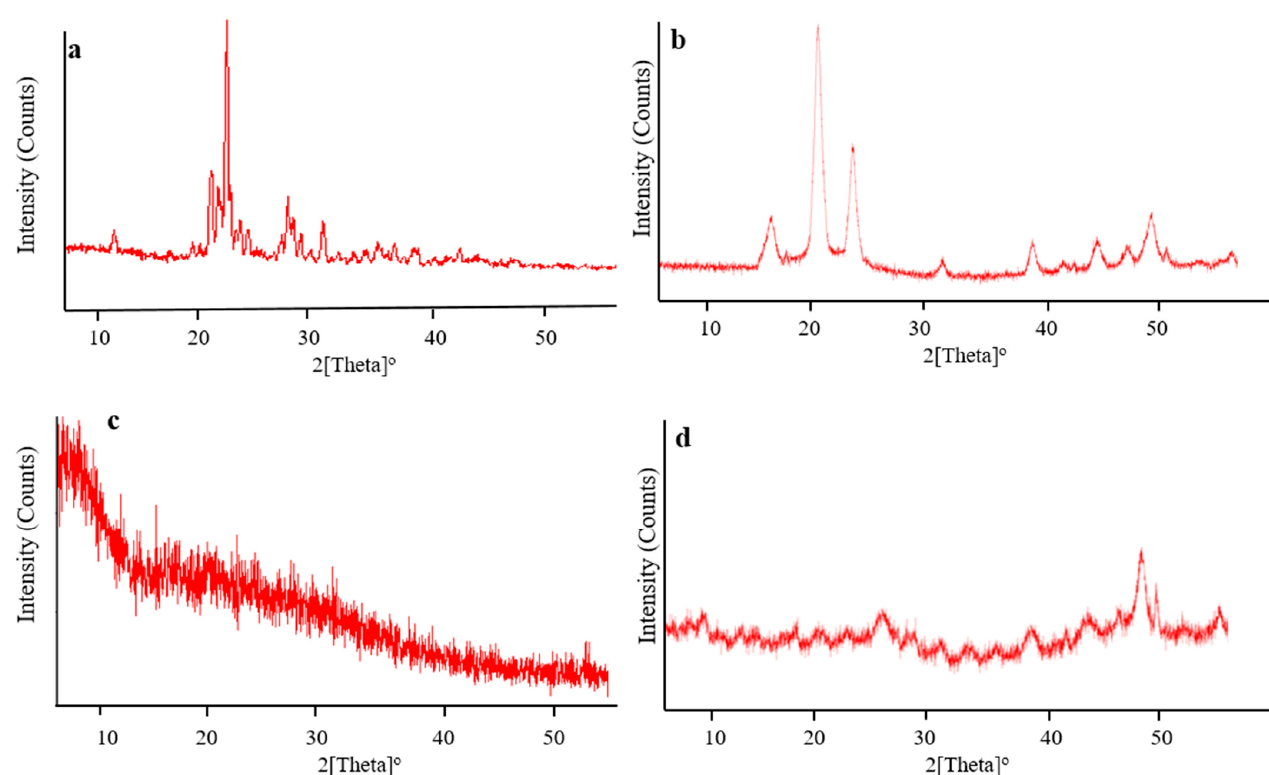
Figure 8. XRD diffractograms of ( a ) CAP, ( b ) chitosan, ( c ) fenugreek gum and, ( d ) drug-loaded hydrogels.